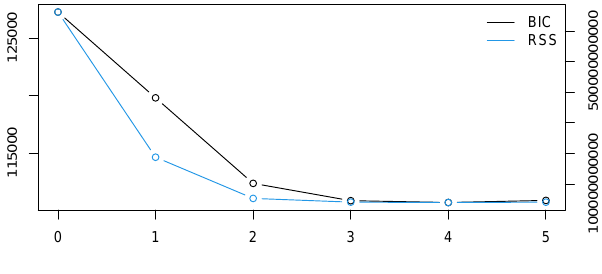
Figure 2. BIC and residual sum of squares.